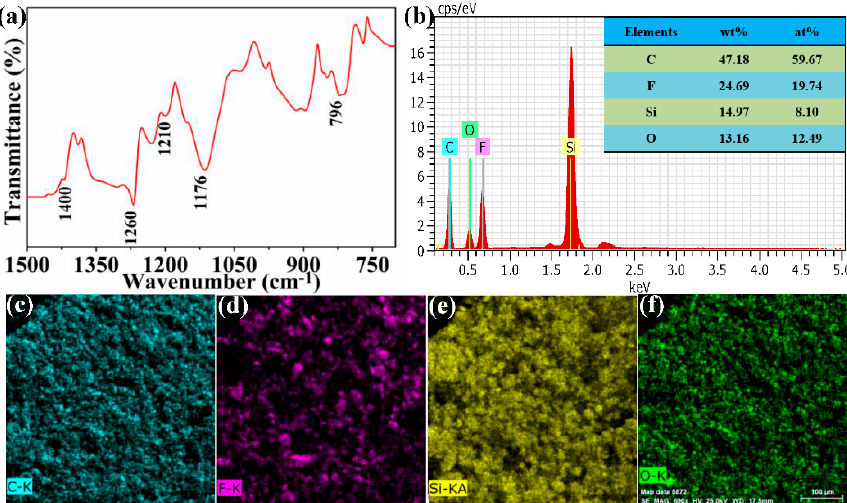
Figure 4. ( a ) FTIR spectra of the FCS coating; ( b ) EDS spectrum of the FCS coating (the inset shows the mass and atomic percentages of the FCS coating surface). Elemental distribution on the FCS coating surface ( c – f ).